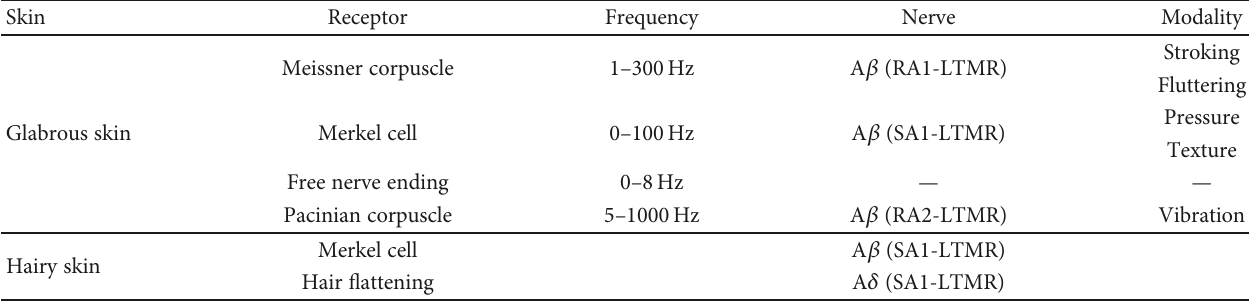
Table 1: Selective combination of mechanoreceptors and